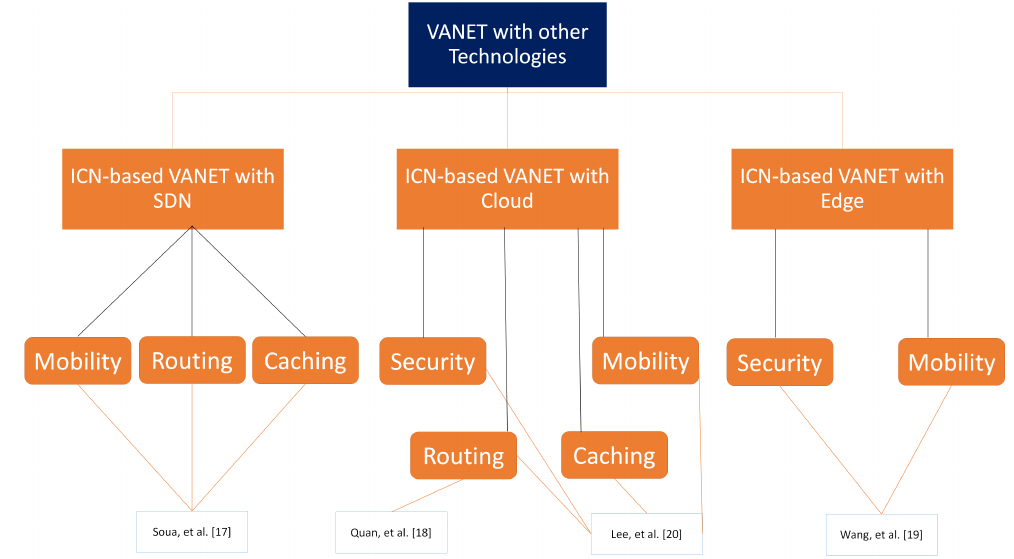
Figure 3. A taxonomy of vehicular network with other emerging technologies based on literature